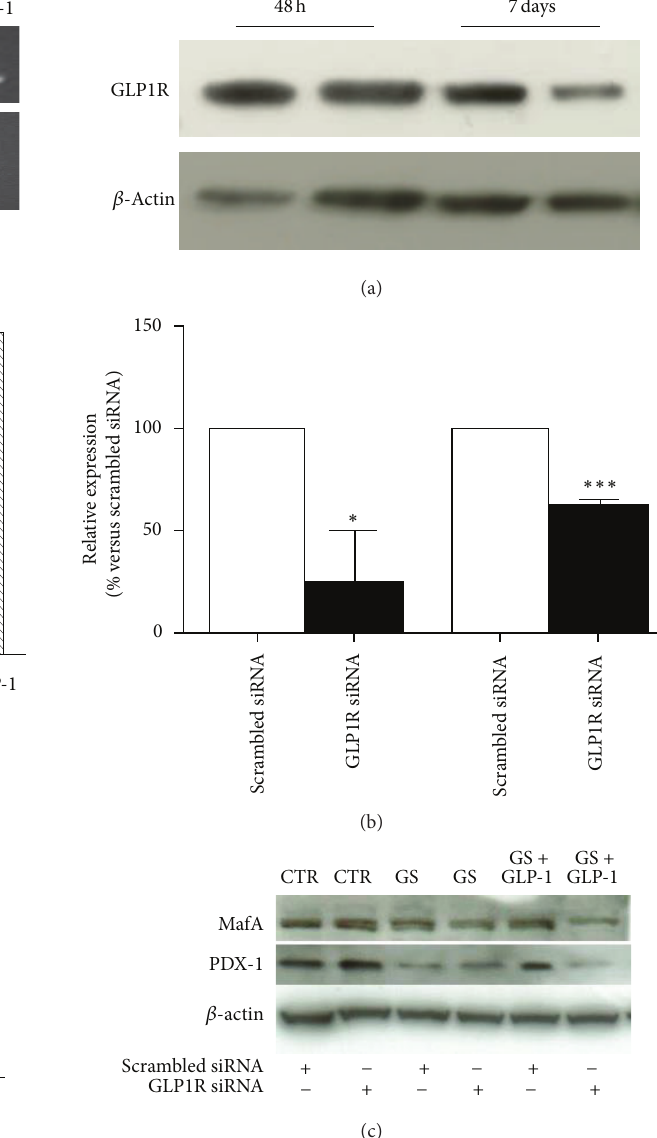
Figure 8: GLP-1 restores proinsulin content in HIT-T15 cells. (a) Semiquantitative RT-PCR for preproinsulin. Representative agarose gel of three different experiments. (b) Quantification of densitome- tries of agarose gel bands. Data are represented as percentage change from CTR level (100%) ( 𝑛 = 3 ). (c) Intracellular proinsulin was measured after acidified ethanol extraction. Data were expressed as mean ± SE of at least 3 independent experiments. ∗∗ 𝑃 < 0.01 and ∗∗∗ 𝑃 < 0.001 versus CTR; §§ 𝑃 < 0.01 versus GS.